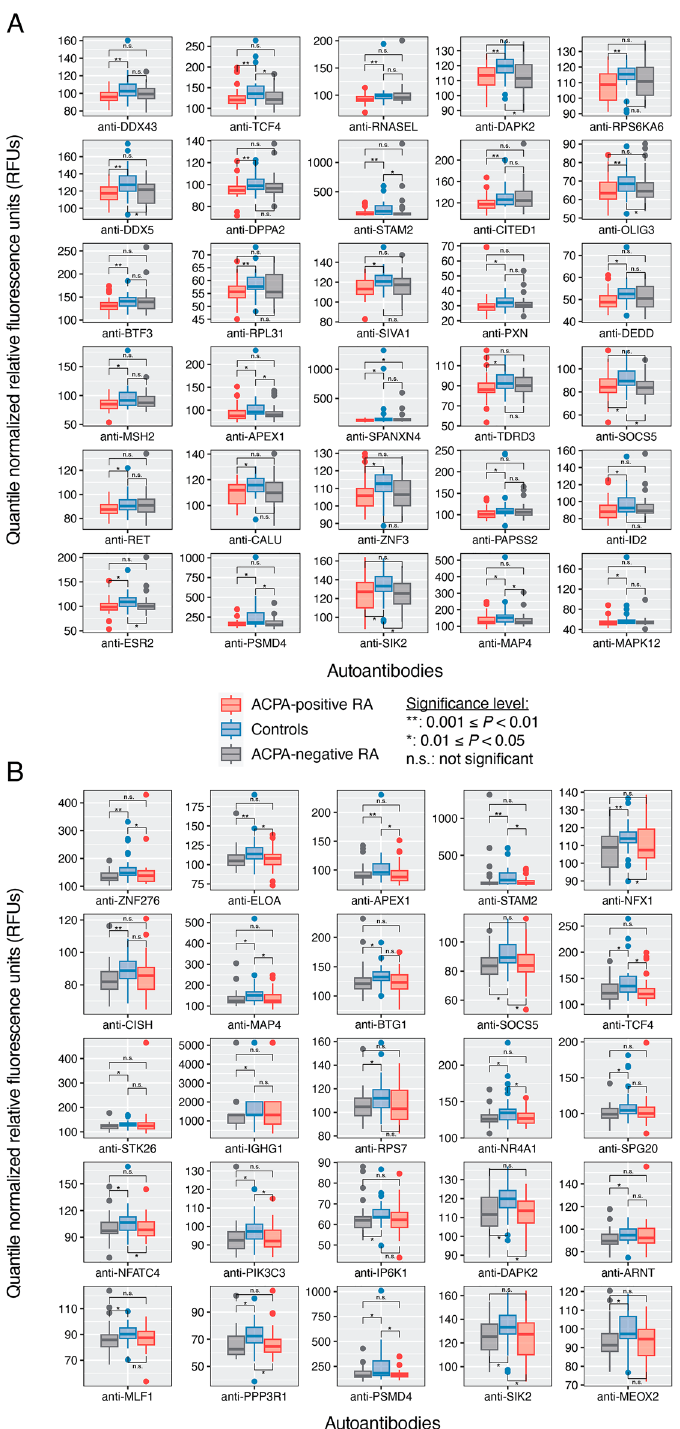
Figure 3. Serum autoantibodies with lower abundances in ACPA+ RA and ACPA− RA than healthy controls. Patients with ( A ) ACPA+ RA ( n = 32) and ( B ) ACPA− RA ( n = 30) show lower abundances in 30 and 25 autoantibodies, respectively, compared with healthy controls ( n = 30). In ( A ) and ( B ), the other RA subgroup is shown for comparison (far right). Two-sided Mann–Whitney U test ( P < 0.05) and Cliff’s delta effect size (| d |> 0.33) were used to find autoantibodies of significantly lower abundances. Standard box-and-whisker plots (e.g., center line, median; box limits, upper and lower quartiles; whiskers, 1.5 × interquartile range; points, outliers) are used to show autoantibody abundances. Eight autoantibodies (anti-APEX1, anti-DAPK2, anti- MAP4, anti-PSMD4, anti-SIK2, anti-SOCS5, anti-STAM2, and anti-TCF4) were found in common to both ACPA + RA and ACPA − RA